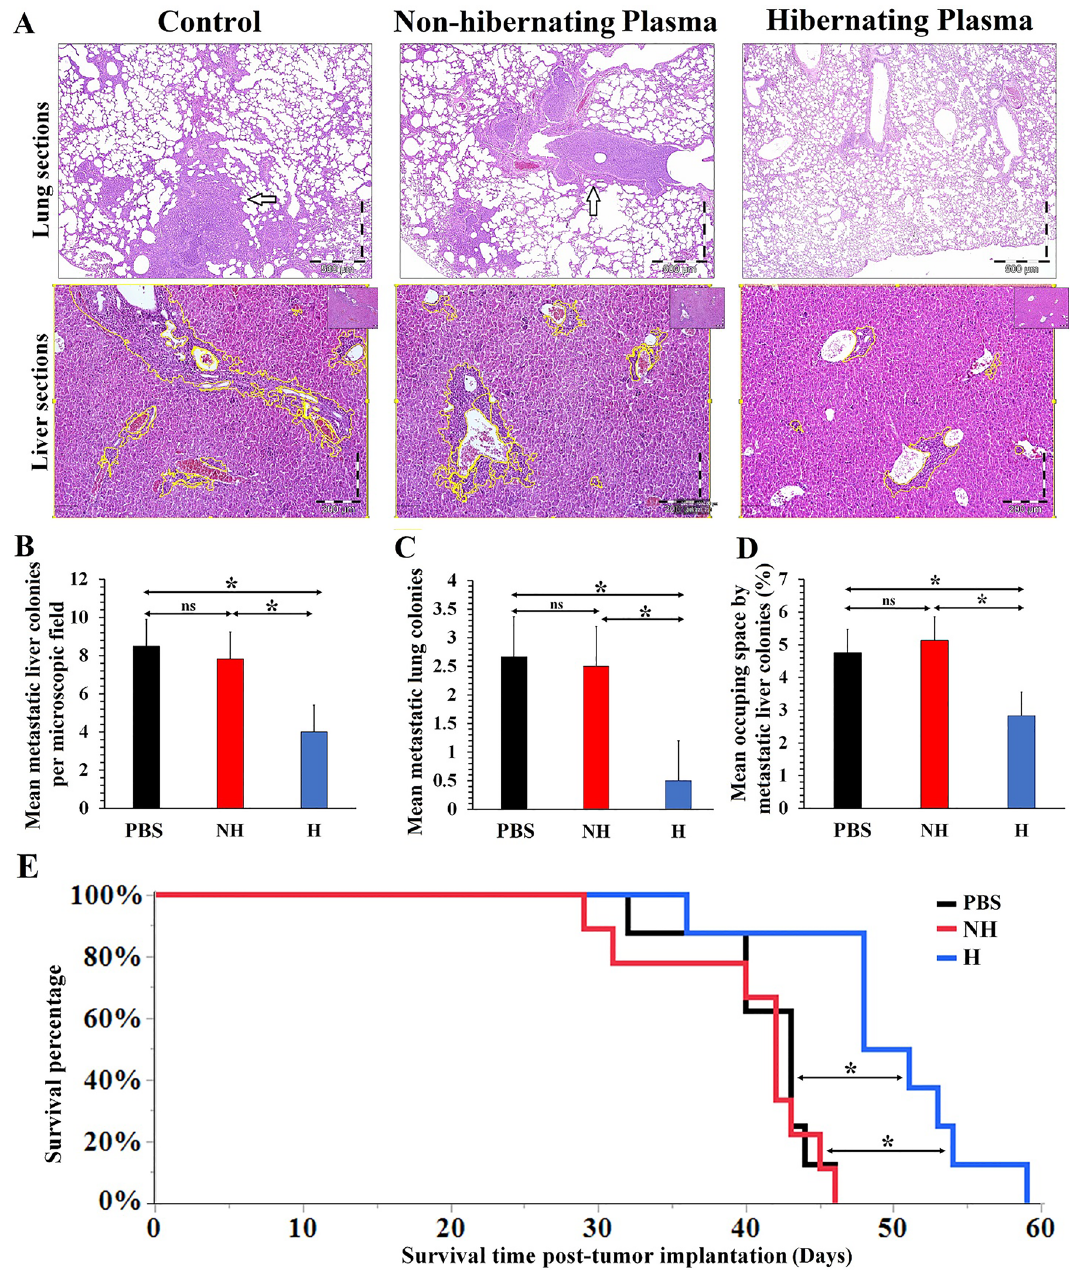
Figure 7. Effect of hibernating plasma treatment on the metastasis and survival time of tumor-bearing mice. ( A ) H&E-stained sections of the lungs and liver of tumor-bearing mice from different groups on the 40th day after cancer cells implantation ( n = 5). The lungs metastatic colonies were pointed by an arrow. Also, the liver metastatic colonies were margined with the yellow lines by the Qupath software. ( B ) Mean number of metastatic colonies in the liver per microscopic field (Magnification × 100) according to H&E-stained sections analysis under a light microscope. ( C ) Mean number of metastatic colonies in the lungs according to H&E-stained sections analysis under a light microscope. ( D ) Mean occupying space by metastatic colonies in the liver per microscopic field (Magnification × 100) according to H&E-stained sections analysis under a light microscope. ( E ) The Kaplan–Meier survival curves of tumor-bearing mice in different groups ( n = 8). ( NH non-hibernating, H hibernating, ns non-significant. *: P <